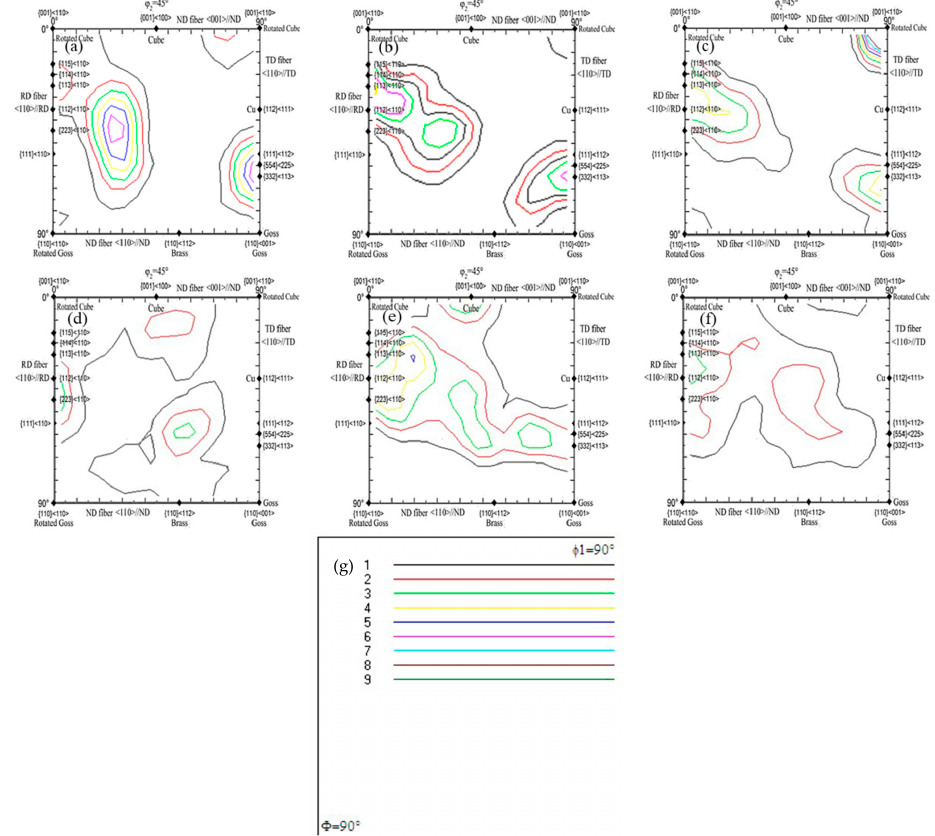
Figure 7. ODF figures under the cross-section of ϕ 2 = 45 ◦ in X100 pipeline steel: ( a – c ) the upper, center, and lower parts along the rolling direction; ( d – f ) Upper, center, and lower in the 30 ◦ direction; ( g ) Annotation of colors.